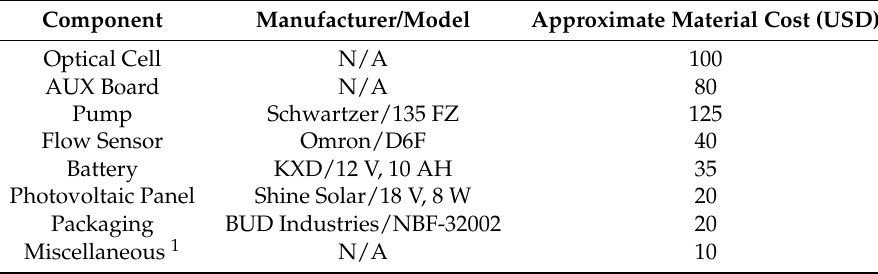
Table A1. Major components of the Aerosol Black Carbon Detector.